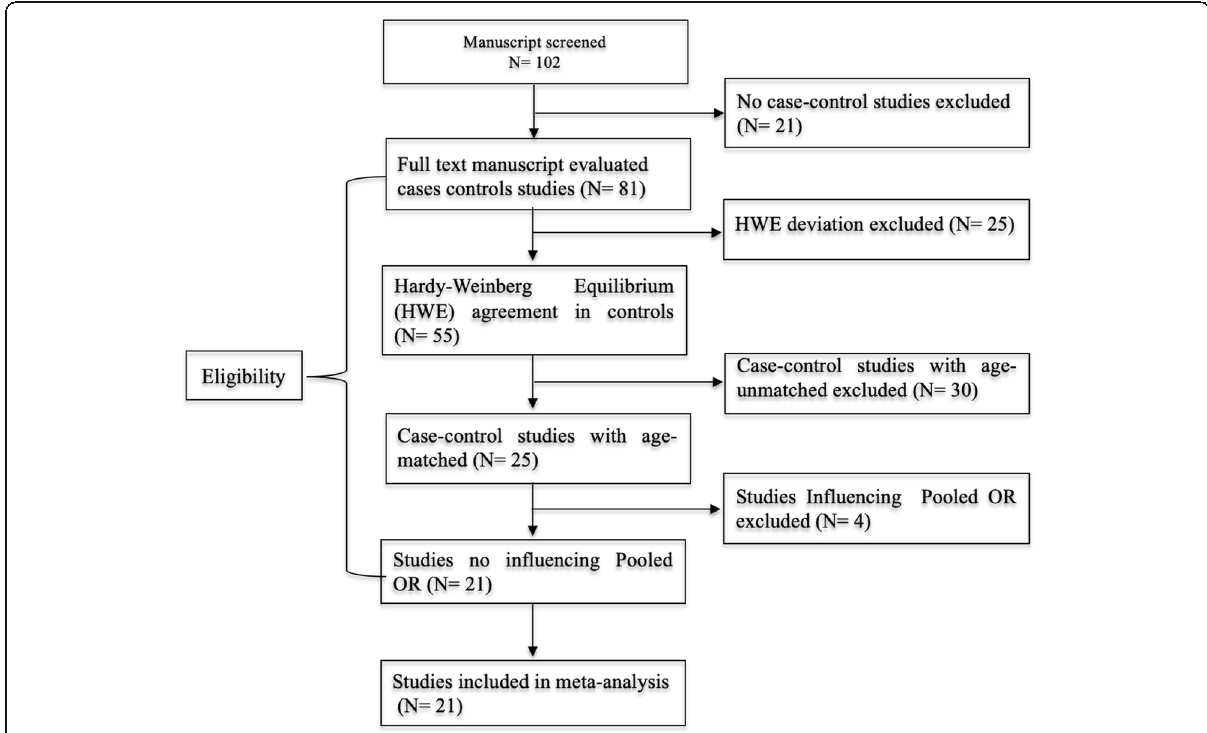
Fig. 1 Flow diagram of the studies evaluated for